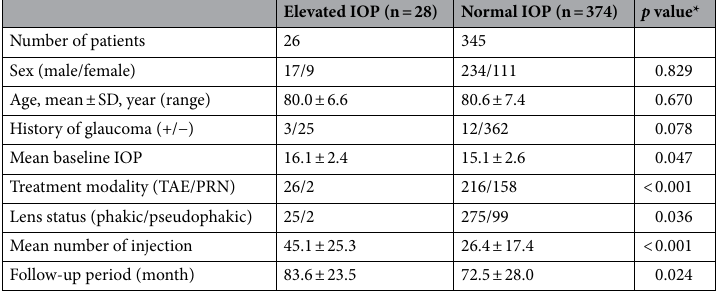
Table 2. Comparison of the clinical features between patients with elevated IOP and normal IOP. IOP intraocular pressure, SD standard deviation, TAE treat and extend, PRN pro re nata. * p value calculated using Welch’s t-test and the fisher’s exact